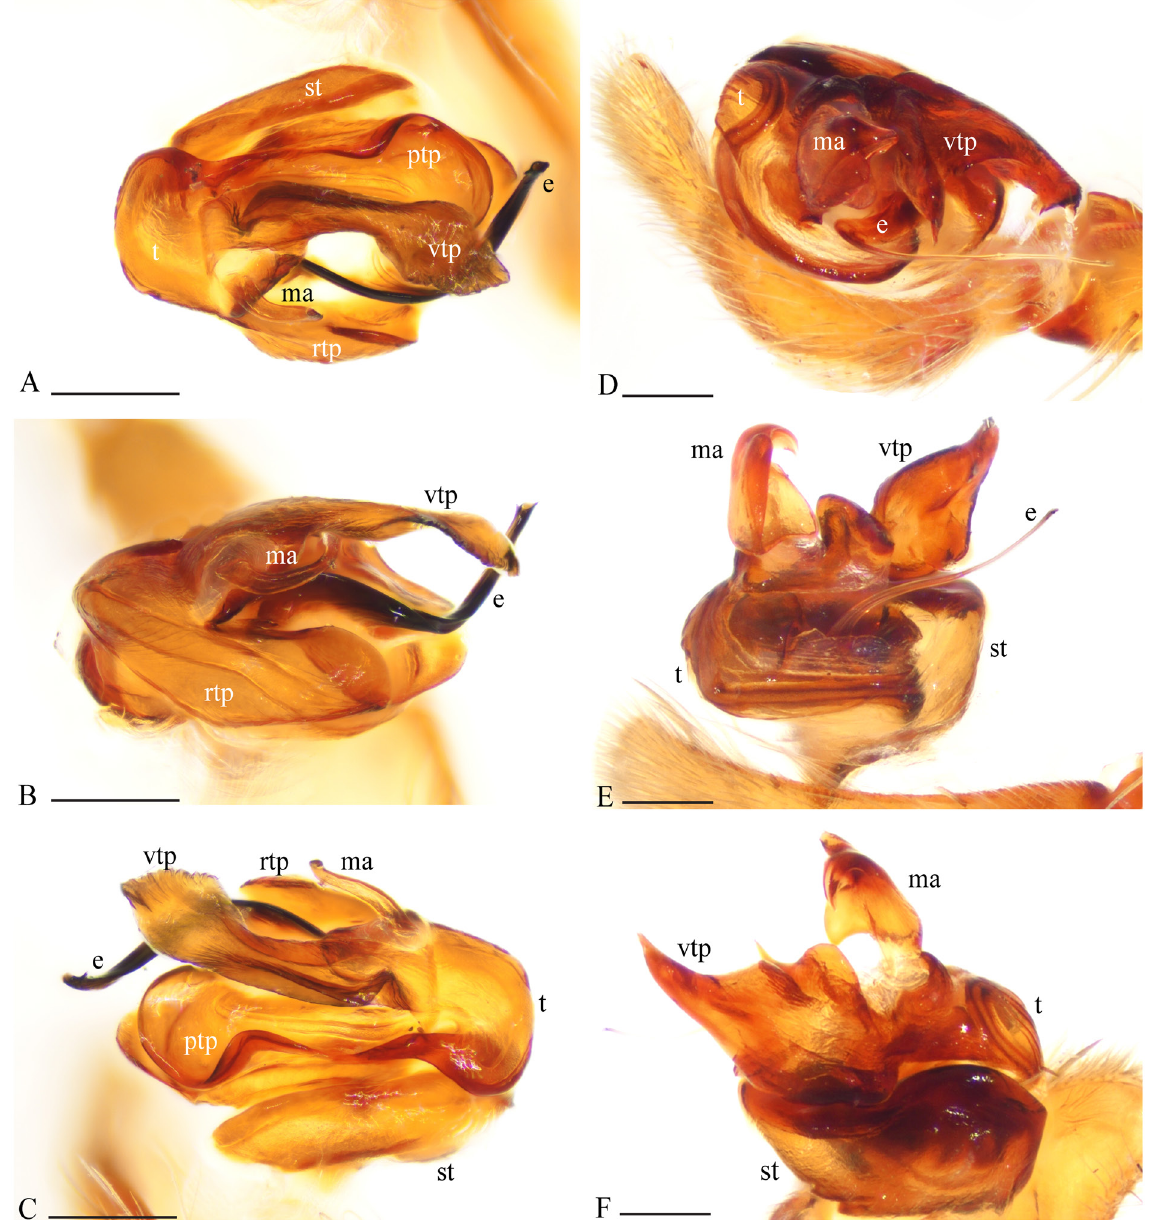
Fig. 1. Anyphaena spp., expanded pedipalps. A–C . A. natachae sp. nov., ♂ (PXF302). A . Ventral view. B . Retrolateral view. C . Prolateral view. – D–F . A. urieli sp. nov., allotype, ♂ (CNAN-T01521). D . Ventral view. E . Retrolateral view. F . Prolateral view. Scale bars: 0.2